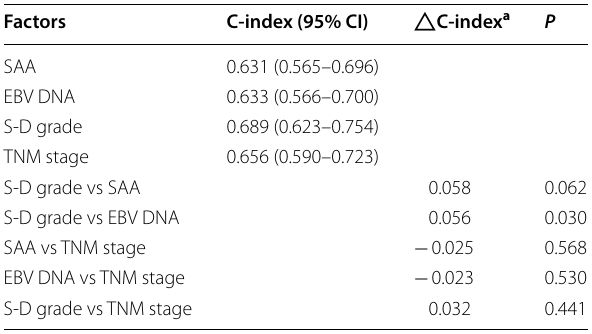
Table 3 The C-index of SAA, EBV DNA, S-D grade and TNM stage for prediction of